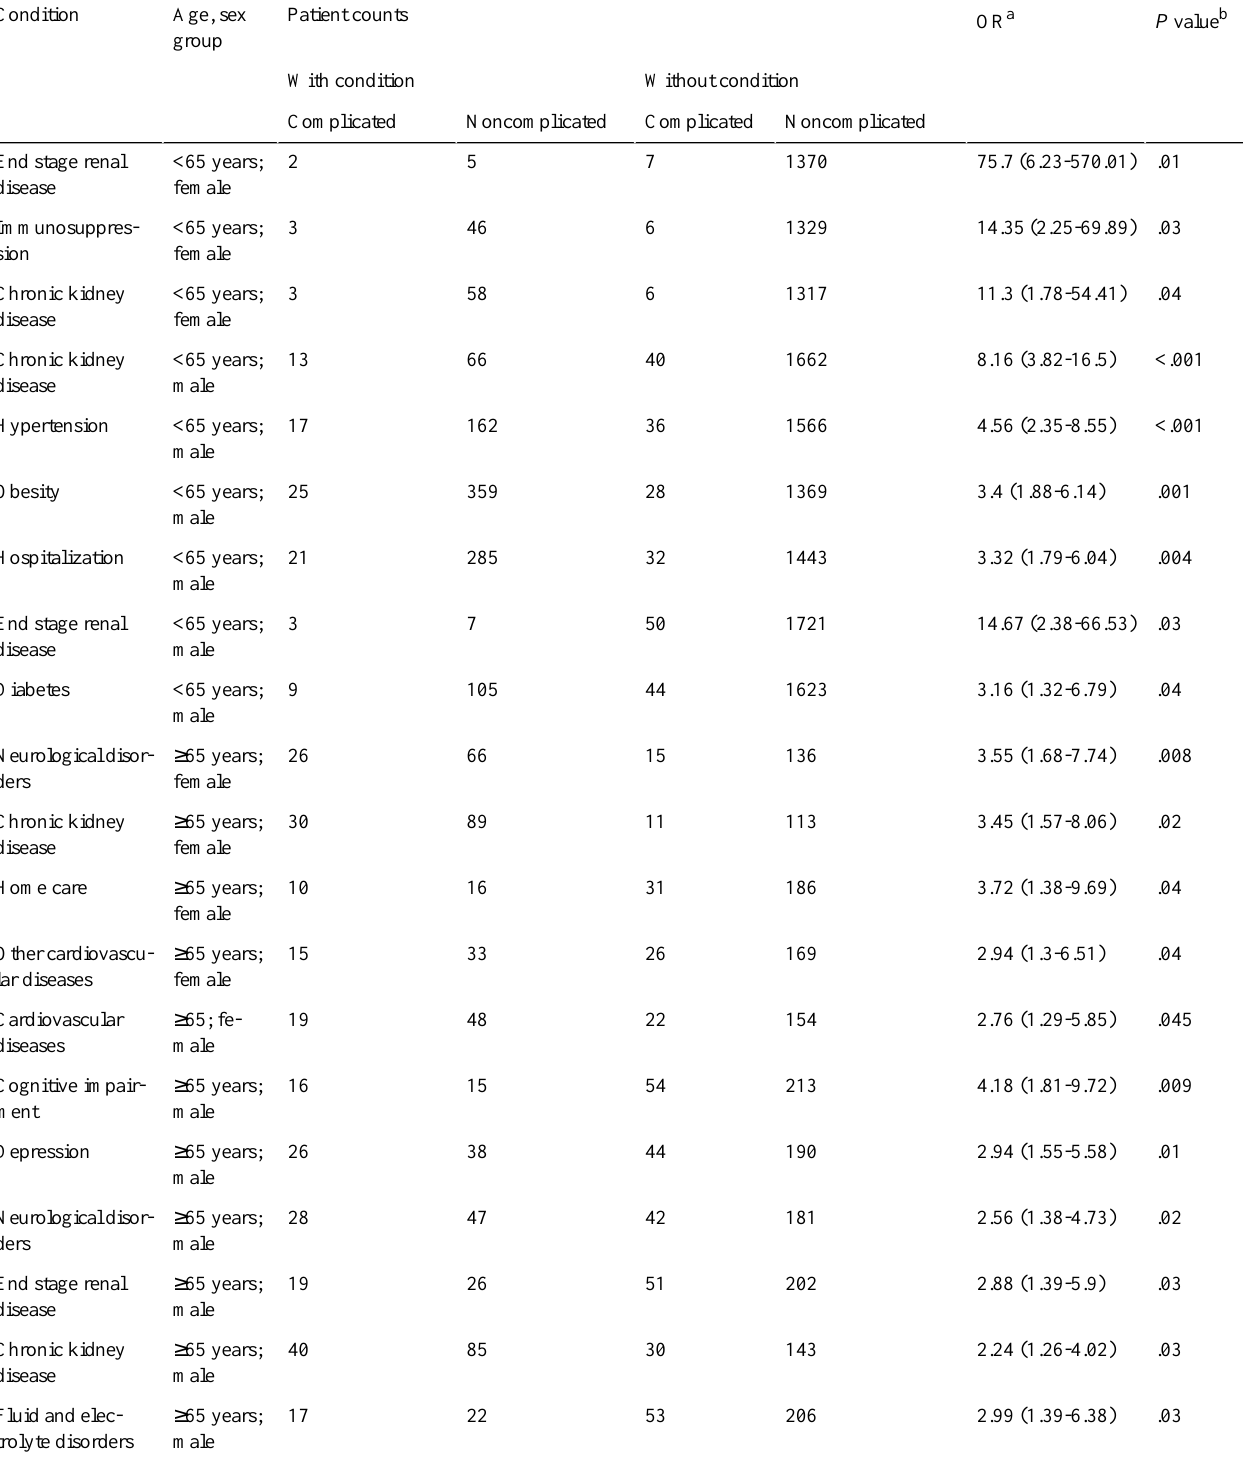
Table 4. Most statistically significant conditions associated with increased risk of COVID-19 complications in age- and sex-stratified patient groups.